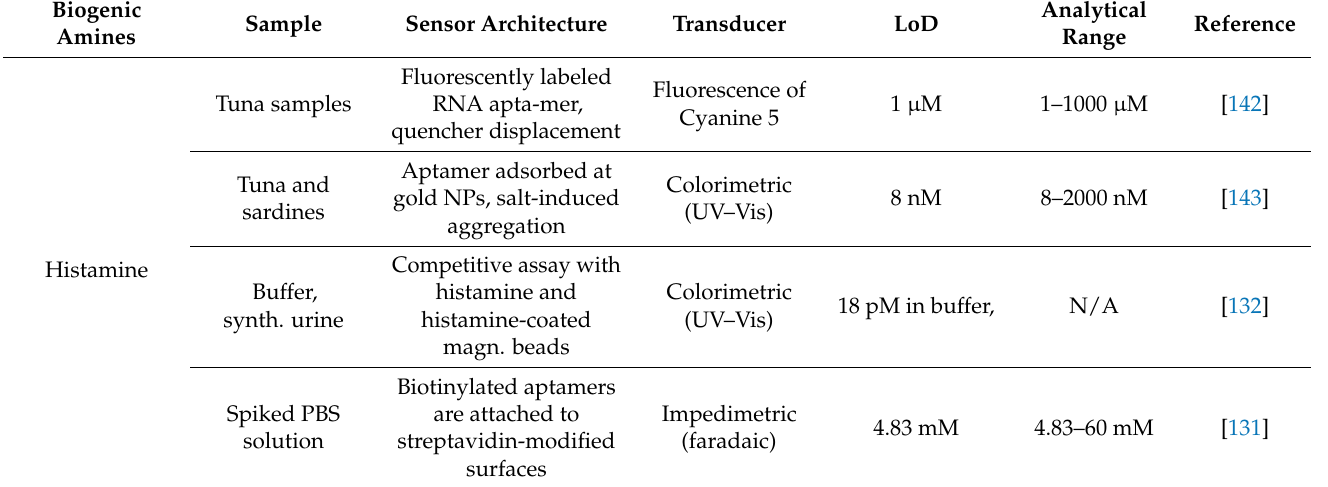
Table 2. Overview of selected biogenic-amine sensors utilizing aptamers as receptors, together with the sensor architecture and the underlying transducer principle. In the case of food items, the samples are aqueous extracts. The limits of detection (LoDs) are used as specified in the original publications, which holds also for the analytically useful